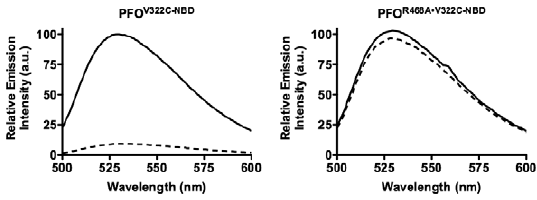
Figure 3. Disruption of the b 4 b 5 interface of PFO and PFO R468A . A cysteine was substituted for Val-322, located in the D3 b 4 strand. Each derivative was labeled with NBD and incubated in the presence (dashed line) and absence (solid line) of human erythrocyte ghost membranes. The fluorescence emission intensity of NBD was measured from 500– 600 nm. The data are representative of 3